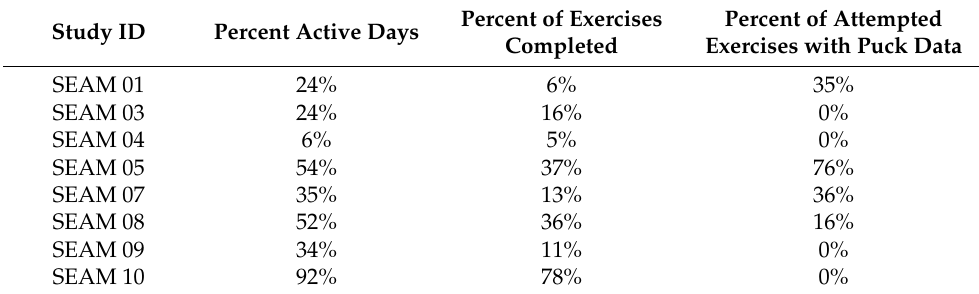
Table 5. Adherence statistics per